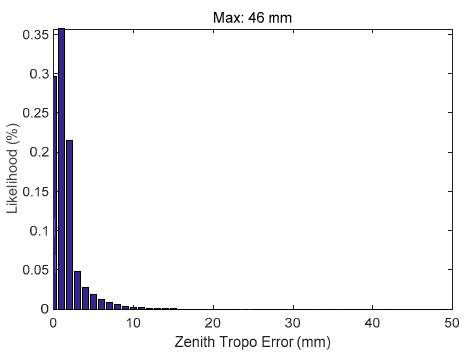
Figure 7. Histogram of the zenith duct error observed at 500 m.